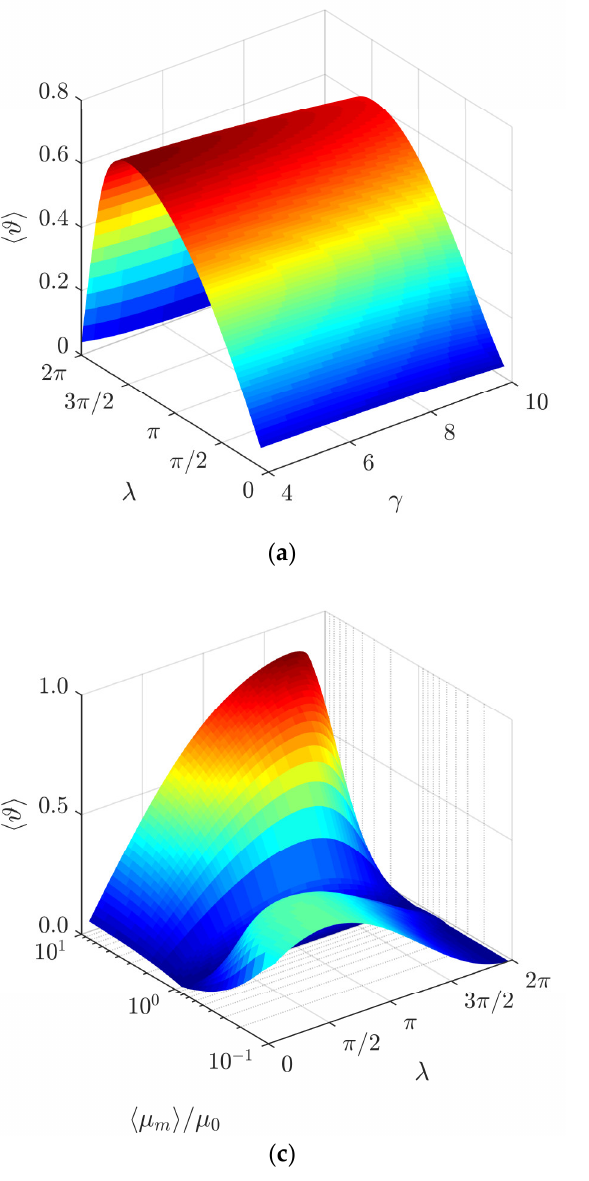
〈 µ 〉 / µ m 0 and λ when µ 0 = 0.1,